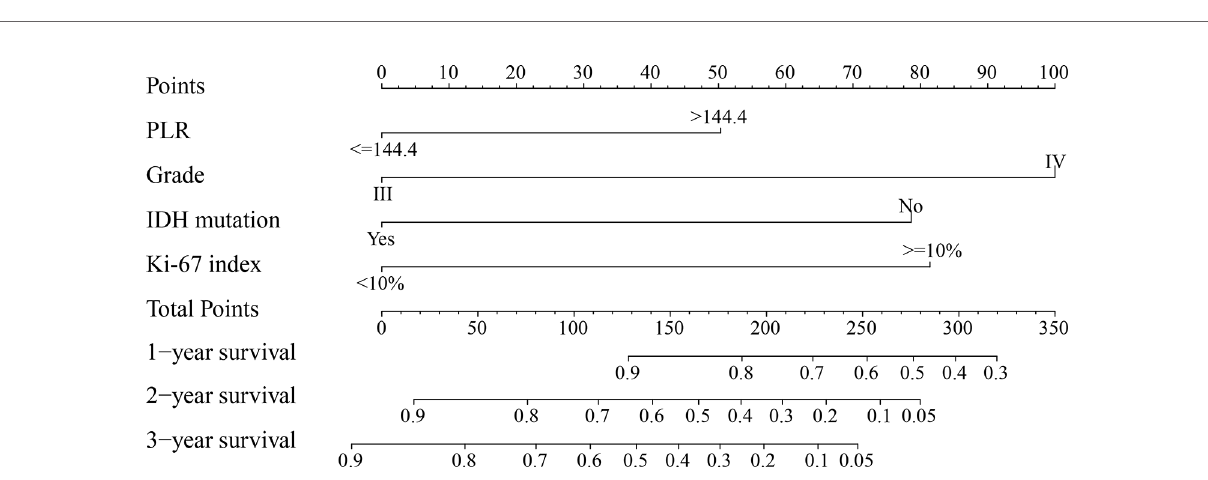
FIGURE 5 | The nomogram for predicting 1-, 2-, and 3-year survival rates of high-grade glioma patients. For each variable, draw a straight line up to the Points axis to calculate the point. After summing the points and locating it on the Total Points axis, draw a straight line down to the 1-year survival, 2-year survival, and 3-year survival axis to determine the probability of surviving for 1, 2, and 3 years. PLR, platelet-to-lymphocyte ratio; IDH, isocitrate